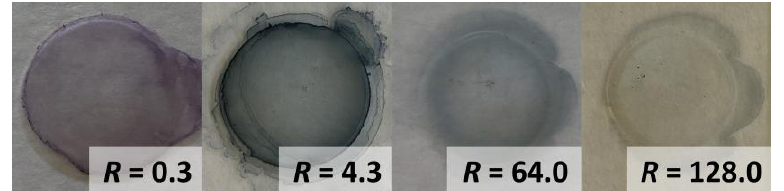
Figure 2. Colors of the synthesized gold nanostructures SiO 2 @AuNS immobilized on a glass substrate depending on the initial seed concentration. The color change indicated a red-shift of the plasmon band with increasing R . Table 1. Overview of [HAuCl 4 ]/[seed] ratio ( R ), extinction maxima ( λ max ), the size of the gold nanostructure (d Au ) as well as the hydrodynamic diameter (d hydr ) and the zeta-potential ( ζ ) of the SiO 2 –NH 2 nanoparticles or rather SiO 2 @AuNP before shell formation and coated SiO 2 @AuNS with varied amounts (1000–2.5 µ L) of SiO 2 @AuNP seed